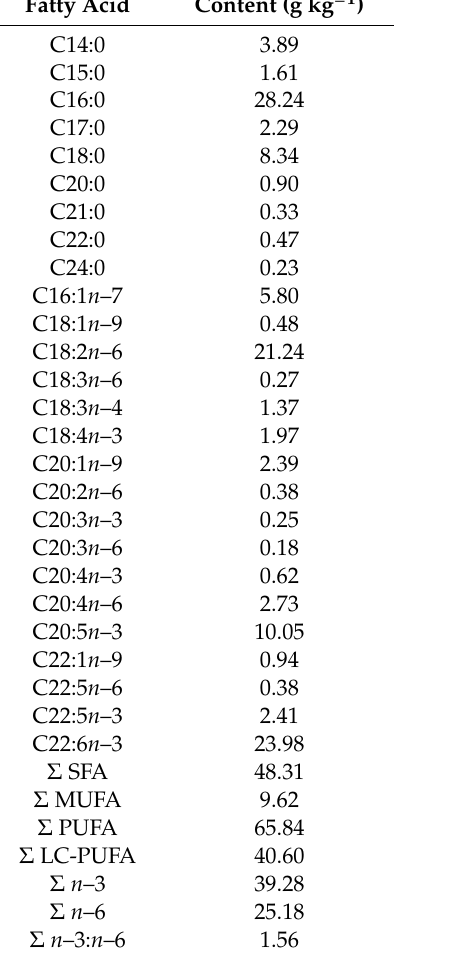
Table 2. Fatty acid contents in SW (g kg − 1 dry weight). The values are averaged from triplicate